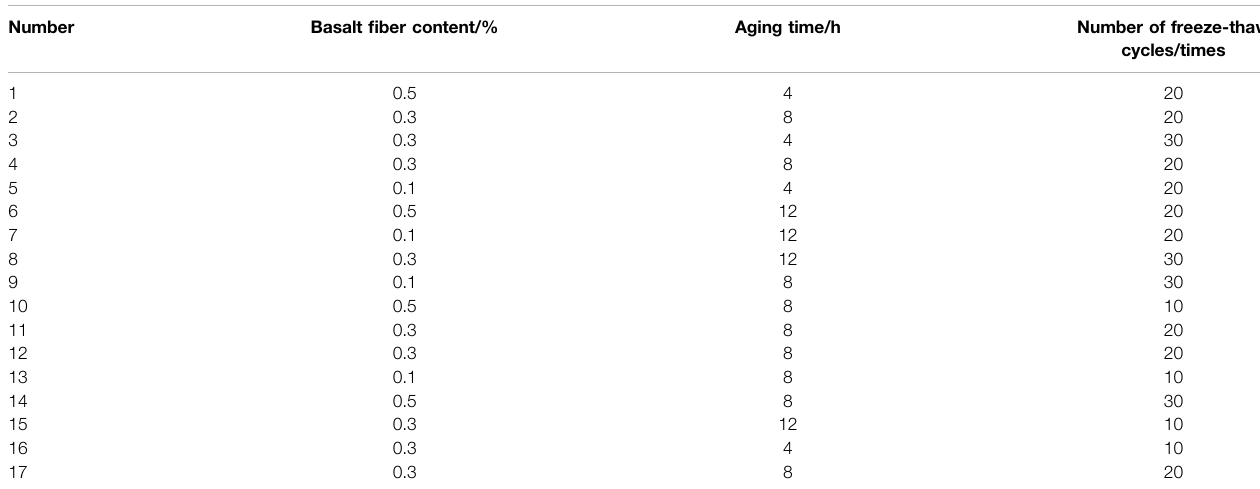
TABLE 7 | Asphalt sample under the different conditions by BBD. Number Basalt fi ber content/% Aging time/h Number of freeze-thaw